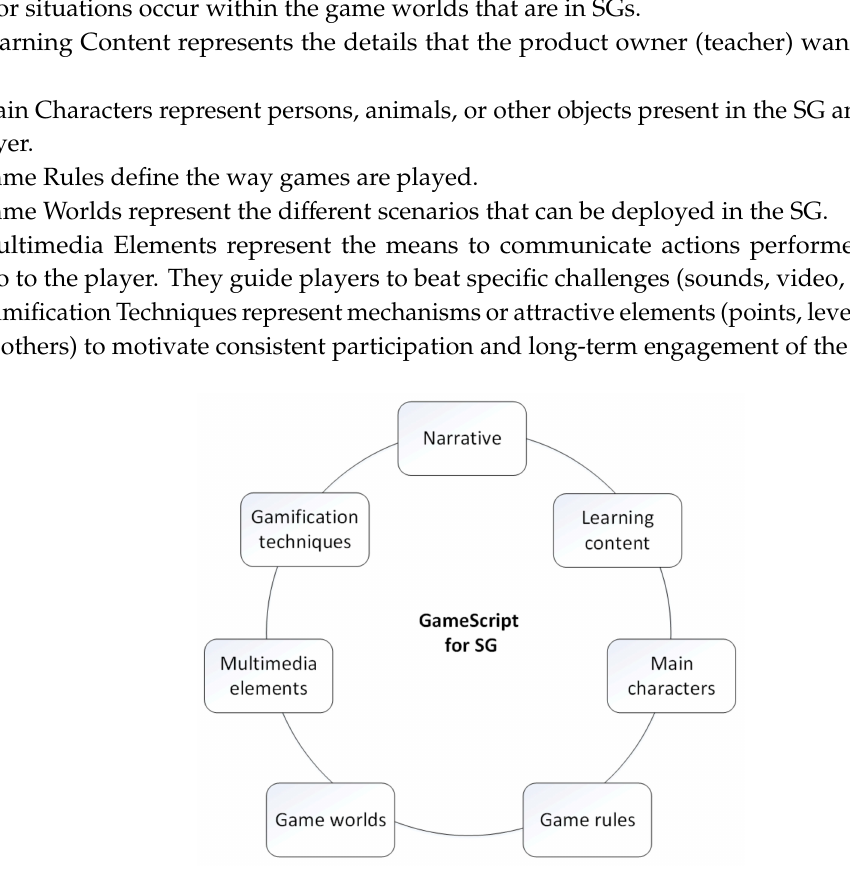
Figure 5. Components of the Ludic Game Script